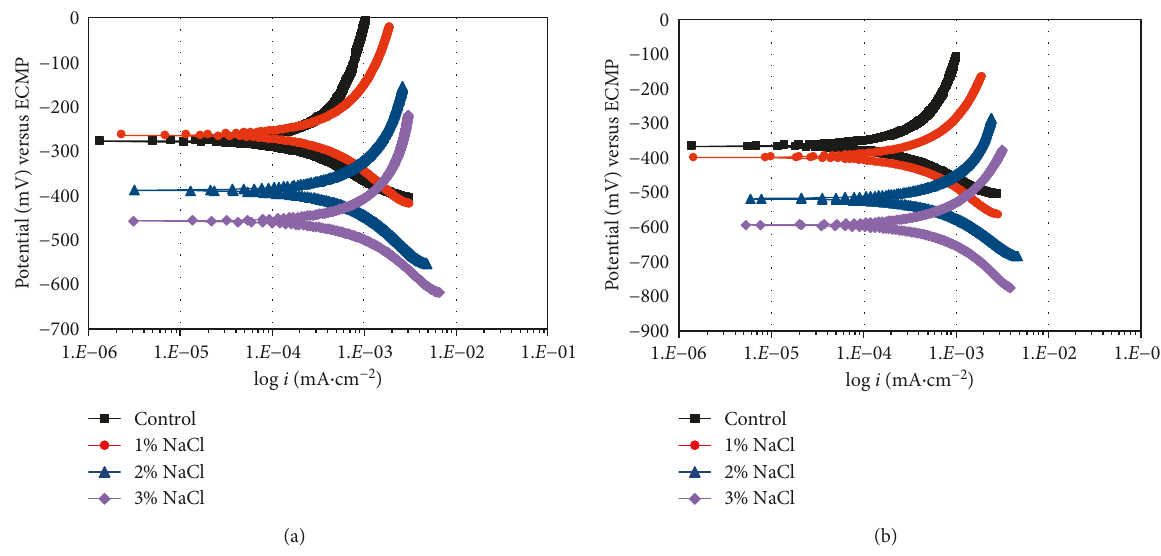
Figure 10: Potentiodynamic polarization curve for the rebar (a) and prestressed steel (b) in chloride-contaminated concrete. Table 4: AC impedance parameters for the rebar and prestressed steel in chloride-contaminated concrete. AC impedance parameters Rebar Prestressed steel System